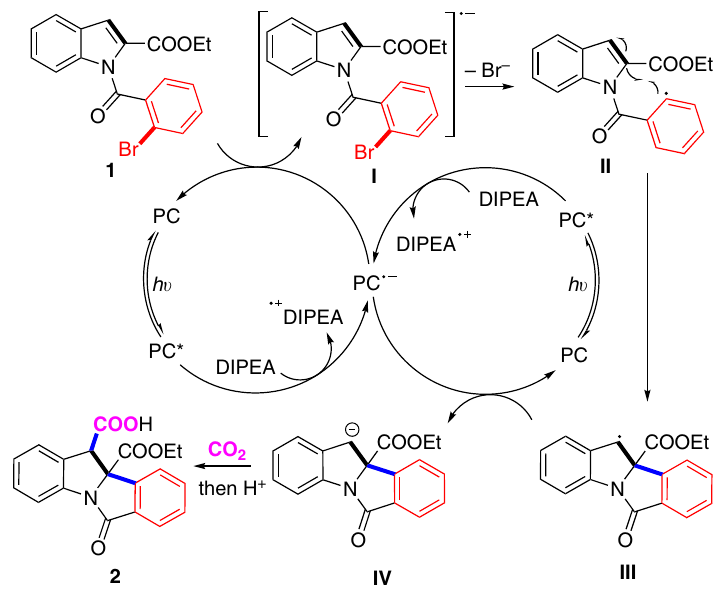
Fig. 8 Mechanistic proposal for the arylcarboxylation of 1. PC =